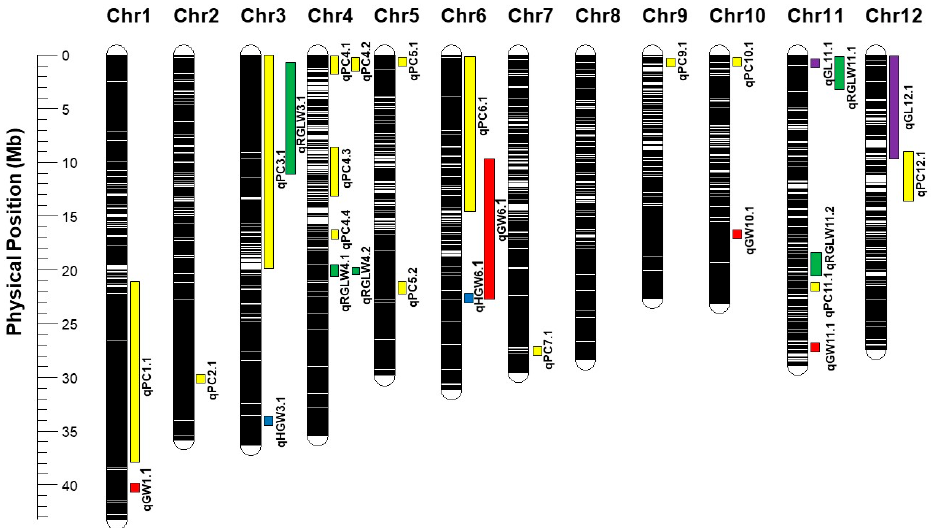
Figure 3. Locations of the QTLs for percent chalk (PC), grain length (GL), grain weight (GW), grain length to width ratio (RGLW), and hundred grain weight (HGW) of K/Z RIL population.